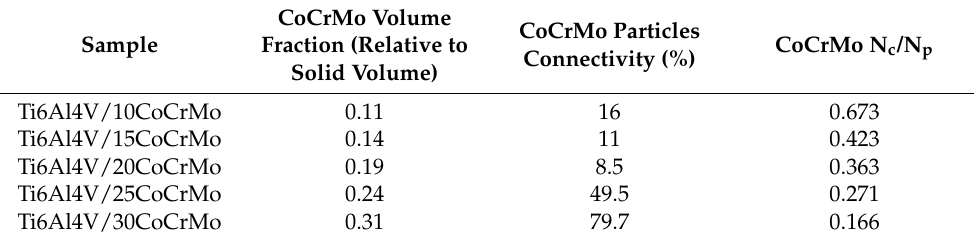
Table 1. Quantitative data of the distribution of CoCrMo particles in the initial